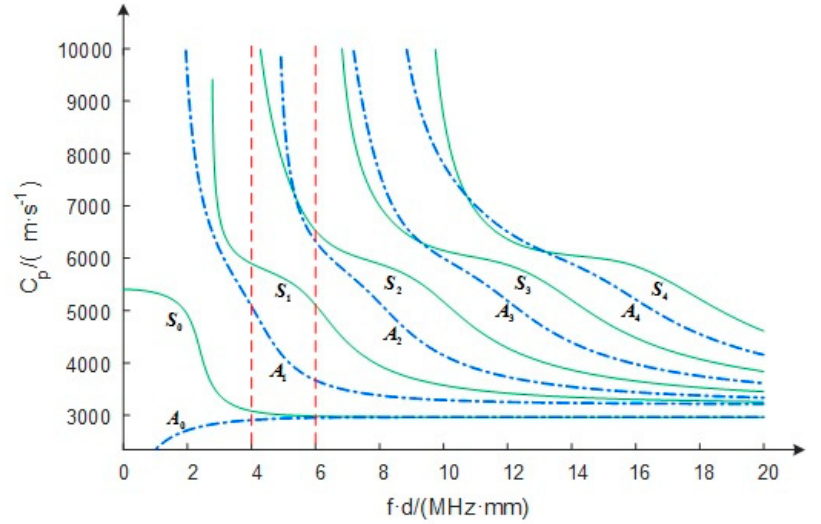
Figure 2. Relationship between the phase velocity c p and frequency-times-thickness fd for Lamb waves in a steel plate (the S-wave velocity was 5970 m / s, the P-wave velocity was 3200 m / s, and Poisson’s ratio was 0.28).